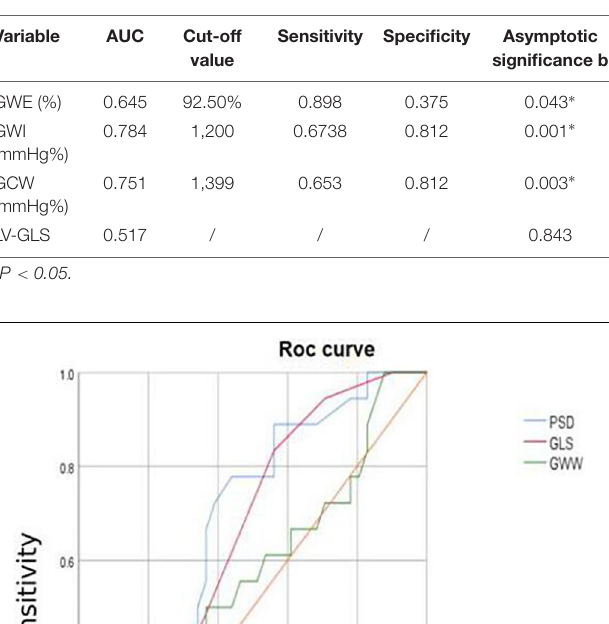
FIGURE 4 | ROC curve of myocardial